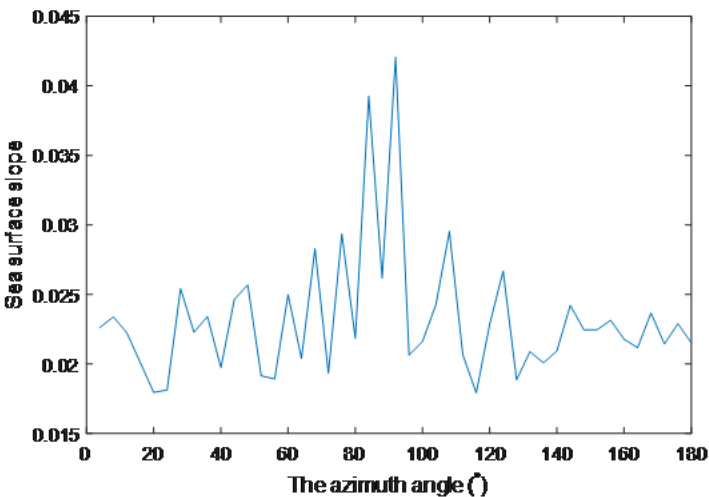
Figure 3. The calculated sea surface slope in the azimuthal direction.